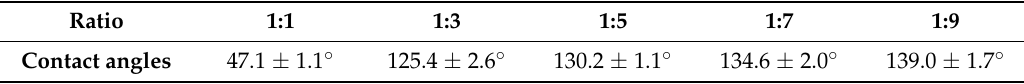
Table 4. Contact angles of PLA/PEG/Cur CNFMs with different weight ratios (PEG:PLA). Ratio